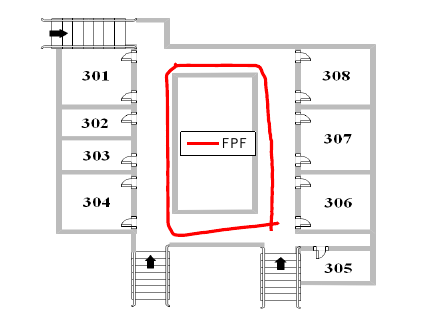
Figure 8. Positioning results for